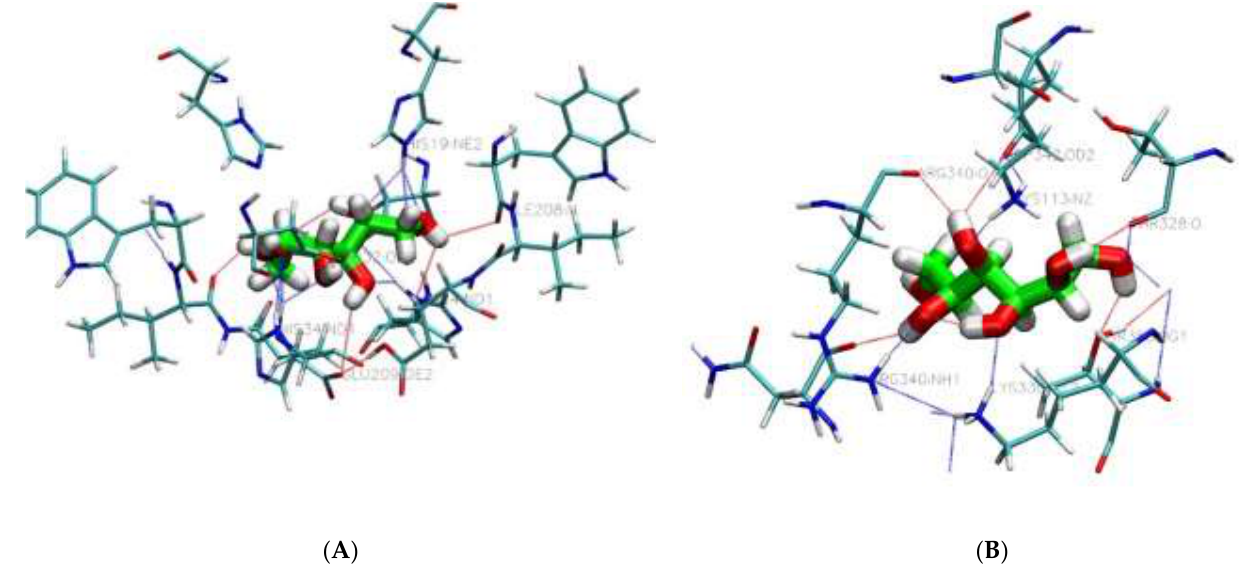
Figure 3. Three-dimensional view of protein – sorbitol interactions of the best poses generated on Canolaprotein ( A ), and Soybean protein ( B ).